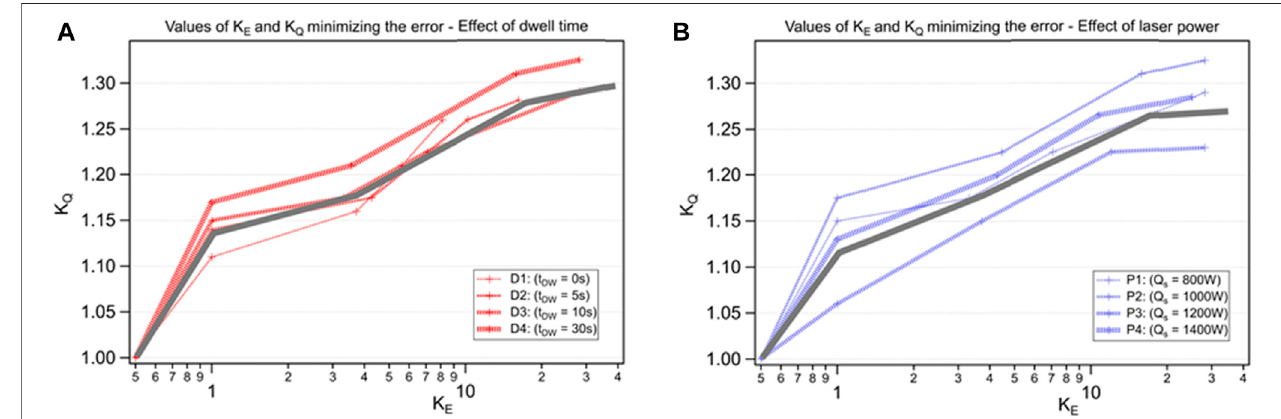
FIGURE 14 | Identi fi cation of a source correction factor (K Q ) for different sub-tract sizes (K E ), for different experiment cases. Recommended correlation between these parameters is pointed out in grey